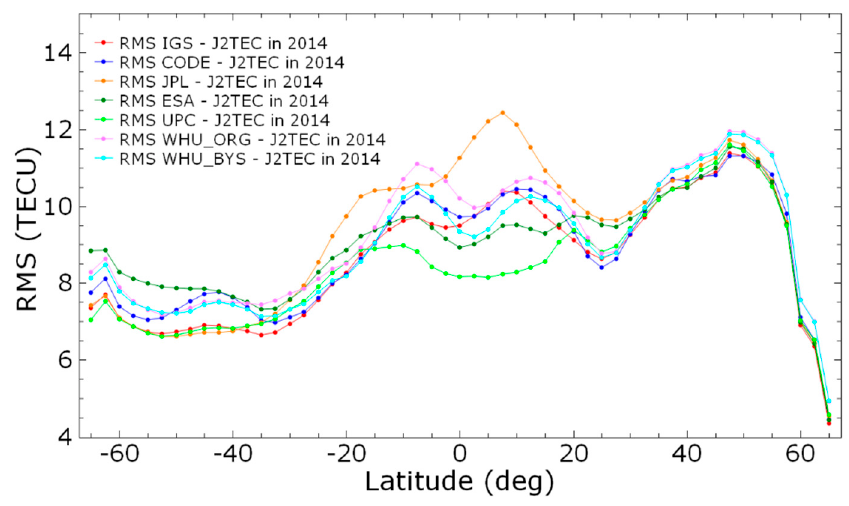
Figure A1. Bias values for comparison between IGS GIMs or IAAC products and J2TEC in 2014.